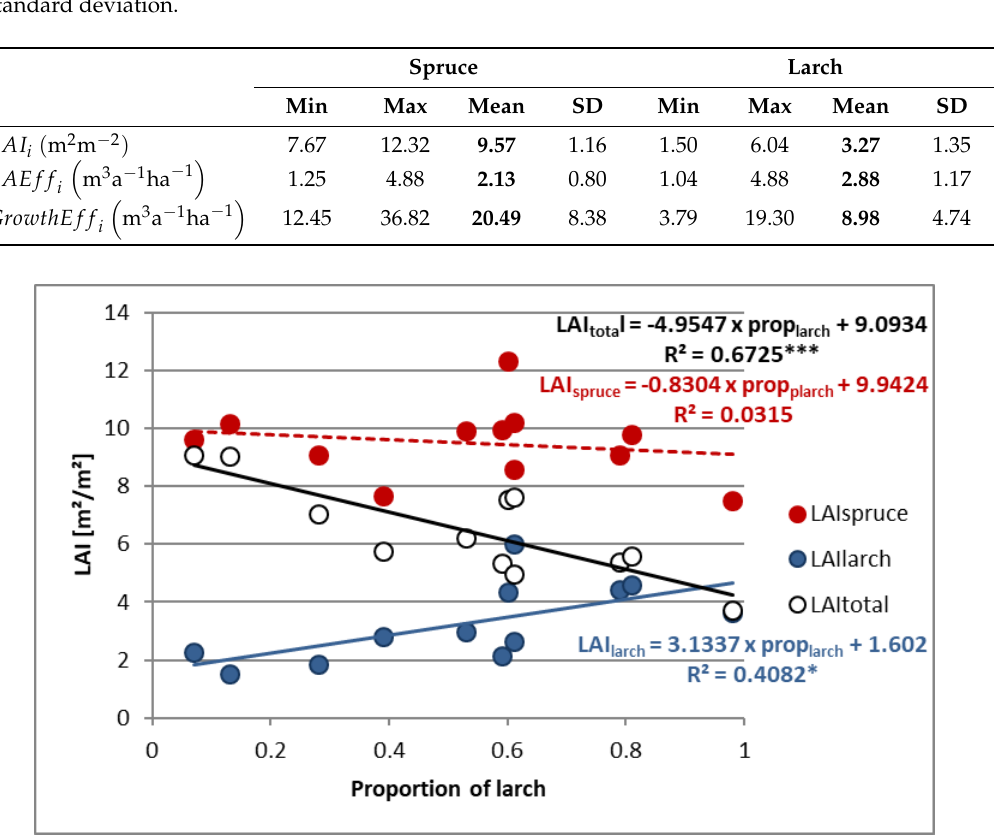
Figure 2. Leaf area index (LAI) by species and in total, depending on the proportion of larch (prop La). * p ≤ 0.05; ** p ≤ 0.01; *** p ≤ 0.001.